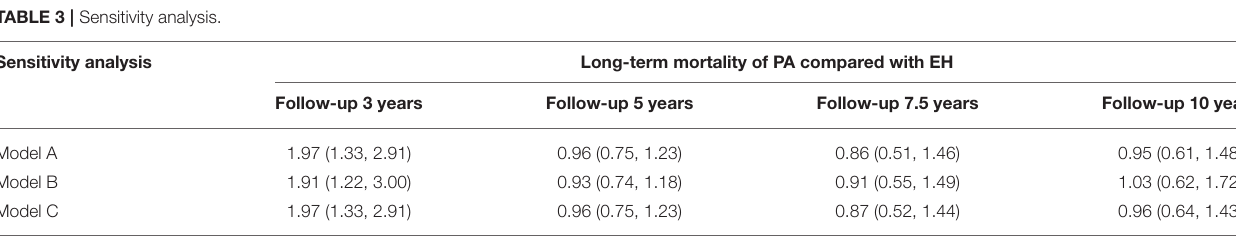
TABLE 3 | Sensitivity